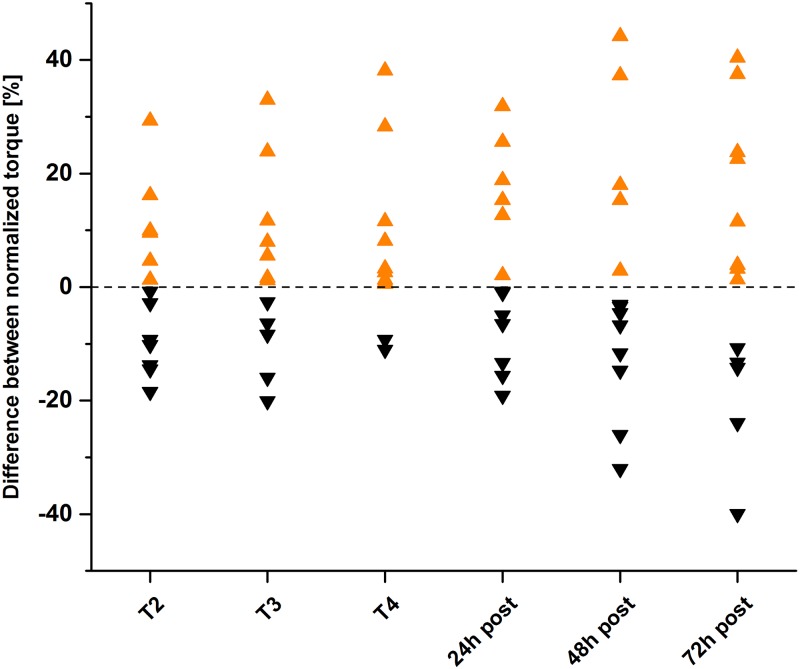
Individual normalized torque differences between baseline MVC measurement and post measurements.Difference between normalized torque for every participant at every testing session. Torque difference was calculated as the difference from normalized MVC Venex minus placebo. Orange symbols show a difference in favour for Venex and black symbols mean a difference in favour for Placebo. If a participant had a relatively higher MVC during the Venex treatment compared to the placebo treatment at a given testing session the value is an orange triangle.